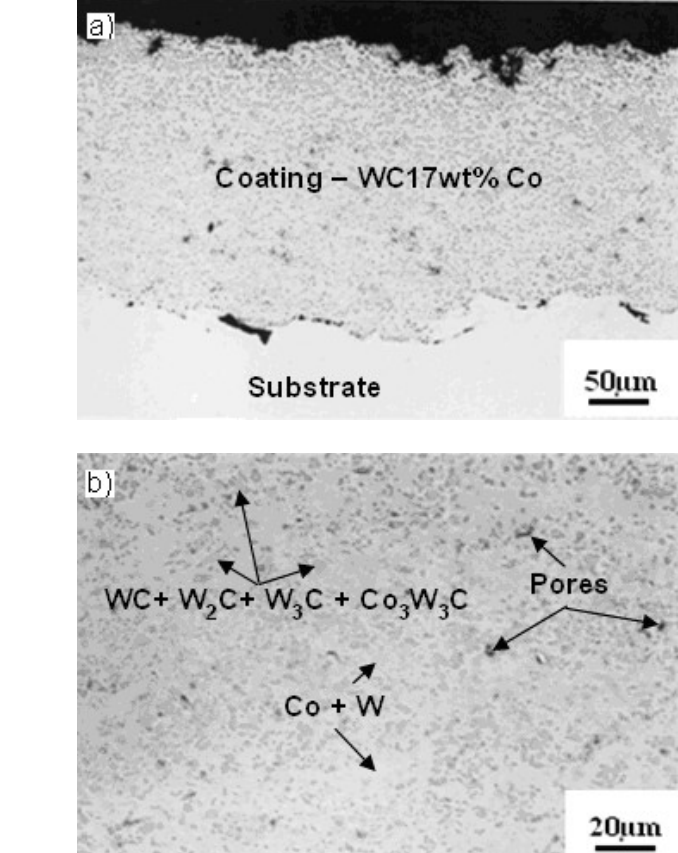
Figure 6 – Microstructure of the WC17Co coating with a plasma gas flow of 22 l / min.He (a) substrate / coating interface and (b) middle layer Slika 6 – Mikrostruktura prevlake WC17Co sa protokom plazma gasa 22 l/min He, (a) interfejs substrat/prevlaka i (b) sredina